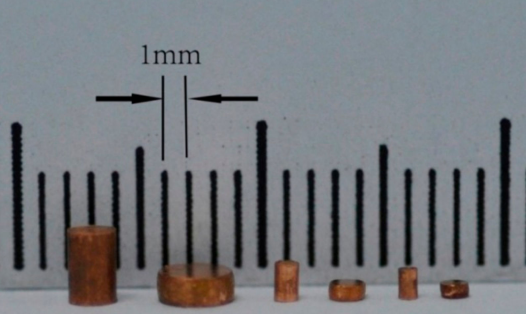
Figure 2. T2 copper cylindrical